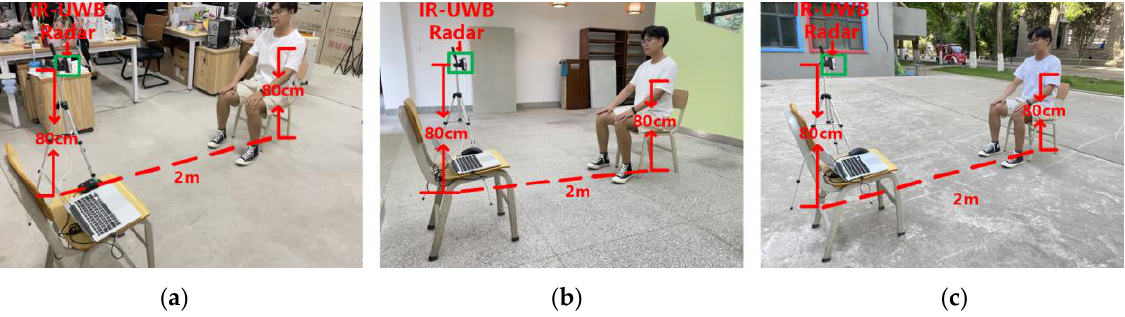
Figure 3. Experimental scene diagram. ( a ) Complex indoor environment. ( b ) Open indoor environ- ment. ( c ) Open indoor environment.